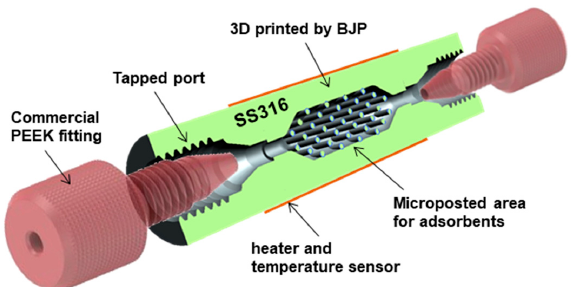
Figure 1. A schematic of the proposed stainless steel (SS) preconcentrator (PC) with commercial PEEK fitting (F-100, IDEX Health; Science Inc.) for fluidic fitting (F-100, IDEX Health; Science Inc.) for fluidic interconnects.